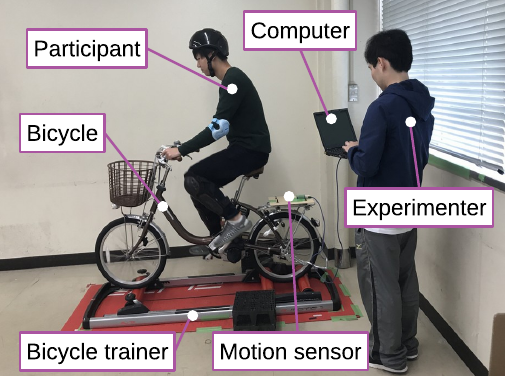
Figure 1. Photograph of our experimental device, a human participant, and an